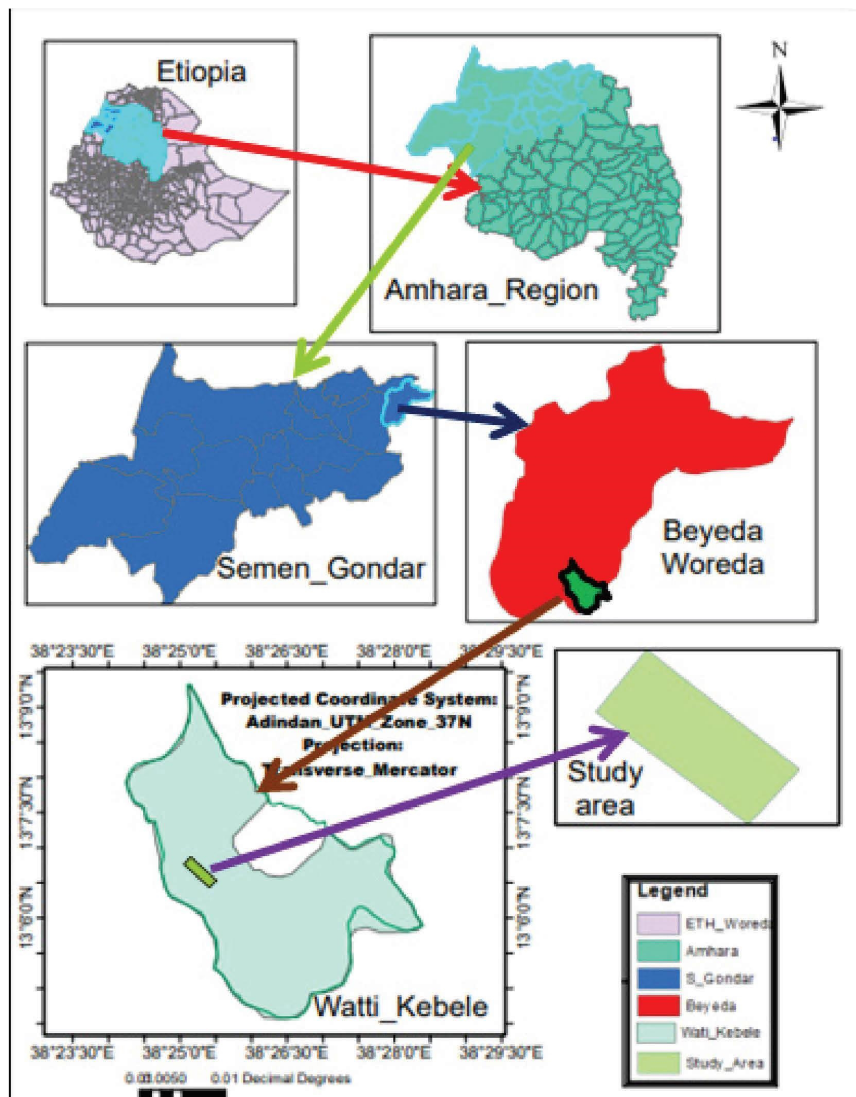
Figure 1: Location map of the study